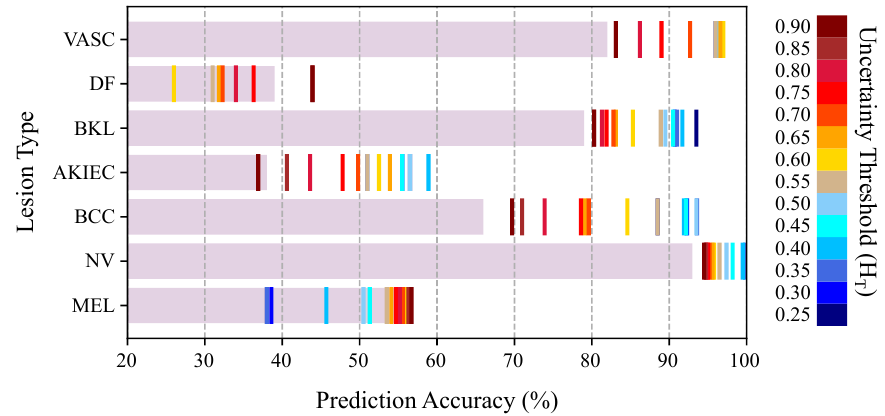
Figure 9. Prediction accuracy of the Bayesian DenseNet-169 model for various skin lesions as a function of the uncertainty threshold ( H T ). The horizontal bars represent the performance of the Bayesian network on all test samples (no referral). The colored vertical lines depict the classification performance for each lesion at a specific uncertainty threshold.